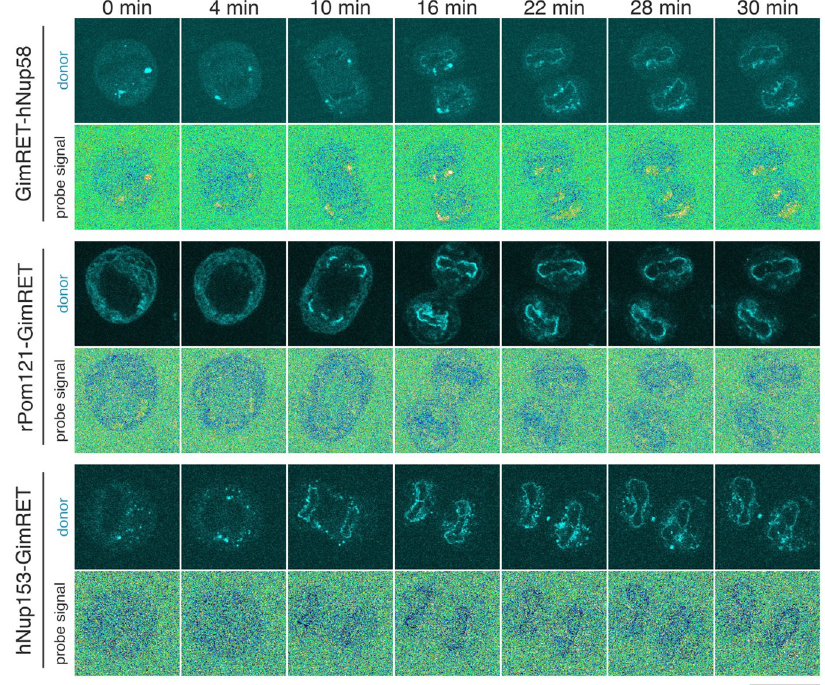
Figure 5. Time-lapse observation of mitotic cells expressing GimRET-fused Nups. HeLa cells expressing GimRET-fused Nups (top, Nup58; middle, Pom121; bottom, Nup153) and mPlum-fused histon H3 were subjected to time-lapse imaging during mitosis. CFP (localization) and probe signals at the indicated time points after anaphase onset are shown. Scale bar: 20 μ